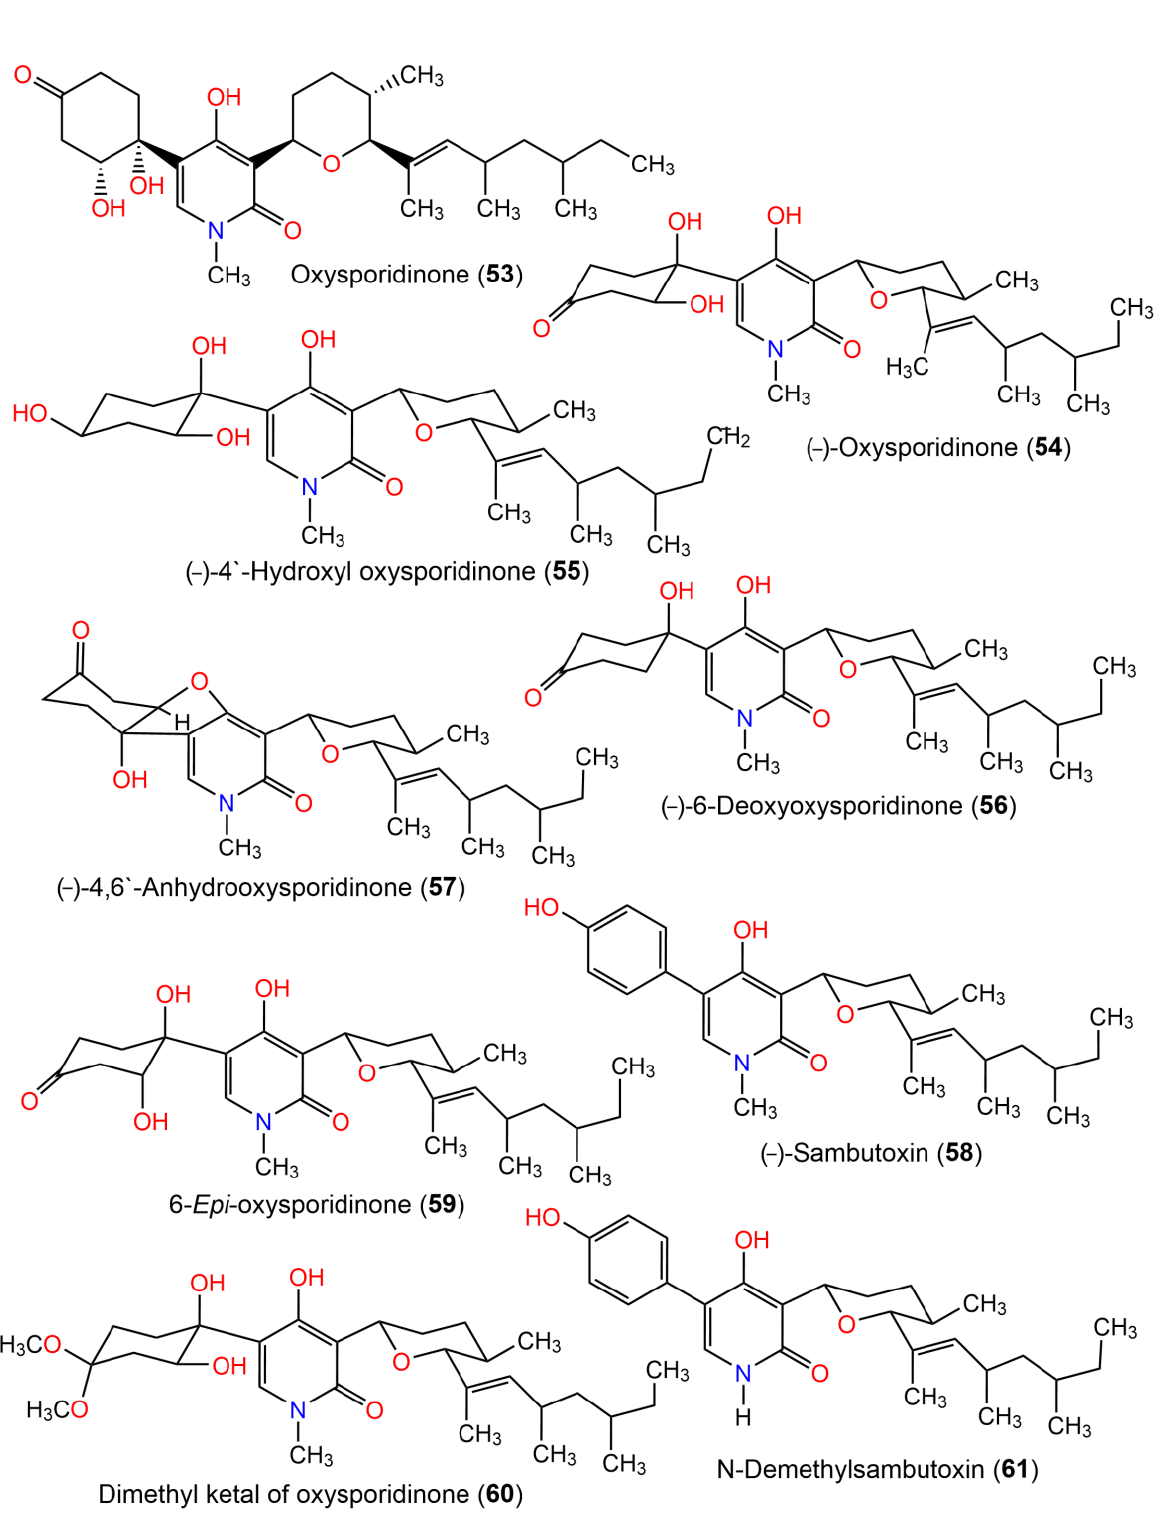
Figure 5. Structures of pyridinone alkaloids ( 53 – 61 ) isolated from F. oxysporum . Compounds 65 , 68 , 69 and 72 showed phytotoxicity towards barley leaves using cot- ton cotyledonary leaf bioassay almost equal to that of fusaric acid, suggesting their prom- ising potential in organic farming. It was suggested that the existence of the C-10-hydroxyl group or C-10 and C-11 double bond led to a decrease in phytotoxicity [69]. Liu et al, postulated the biosynthetic pathway of fusaricates A-G ( 65 – 71 ). Isotopic 13 C and 14 C tracer studies revealed that C-2 to C-4 and C-7 of fusaric acid were originated from oxaloacetate, while C-5, C-6, and C-8 to C-11 were derived from three acetate units [189,190]. The nitro- gen atom of pyridine ring is originated mainly from glutamine [191]. The formation of